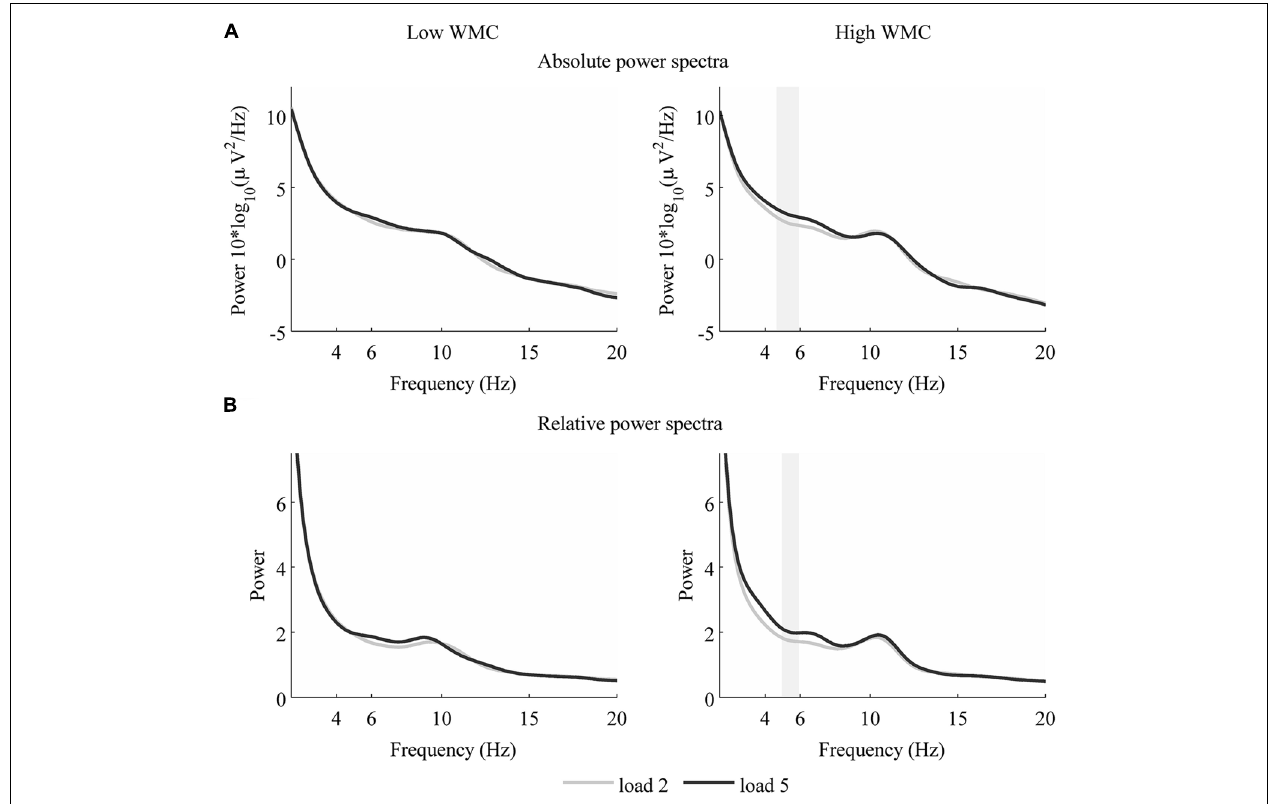
FIGURE 3 | Power spectrum for loads two and five – for lowWMC (left) and highWMC (right) group absolute (A) and relative (B) theta power from loads two and five. Shaded area indicates significant differences in power between the two loads ( p < 0.05).